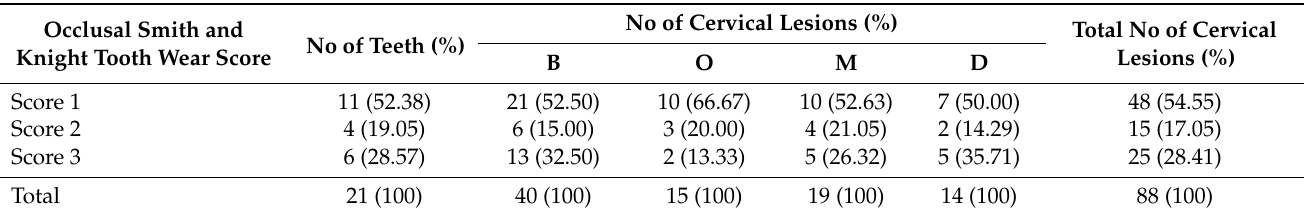
Table 2. Cervical lesions distribution according to occlusal wear score and affected surface (B = buccal, O = oral, M = mesial, D =